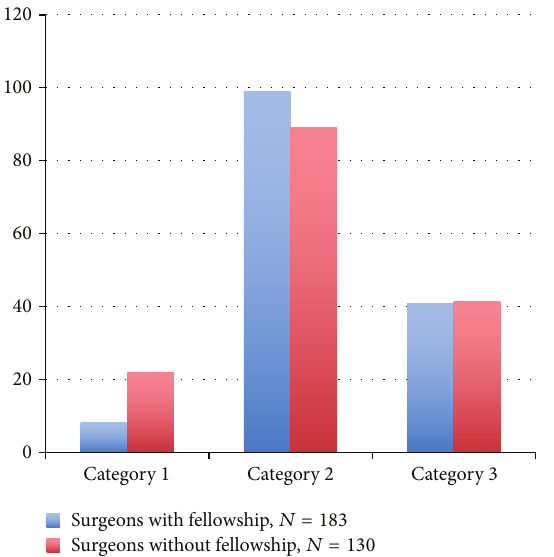
Figure 1: Percent agreement comparison of fellowship and nonfel- lowship trained orthopaedic surgeons.